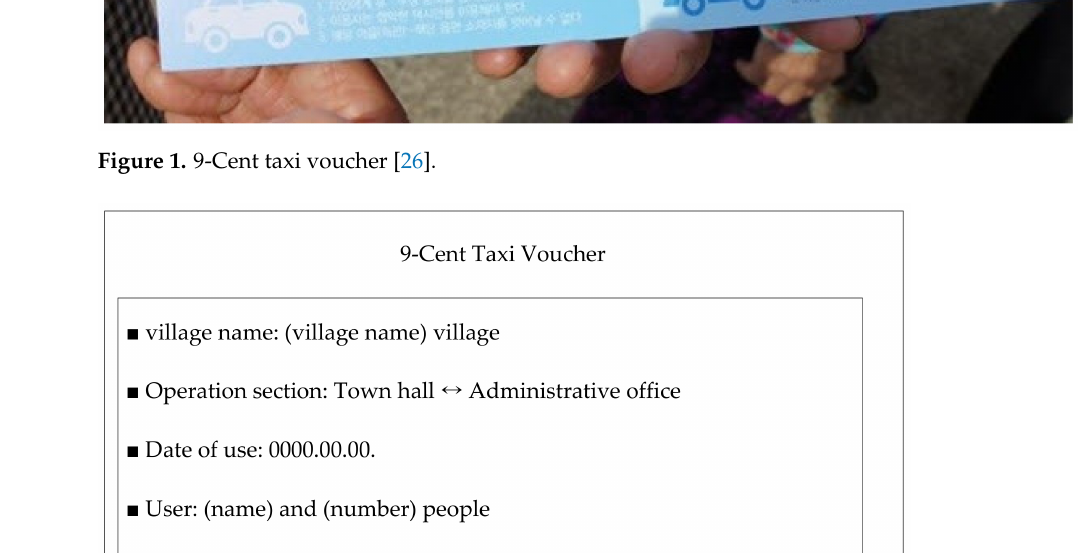
Figure 2. 9-Cent taxi voucher contents in English